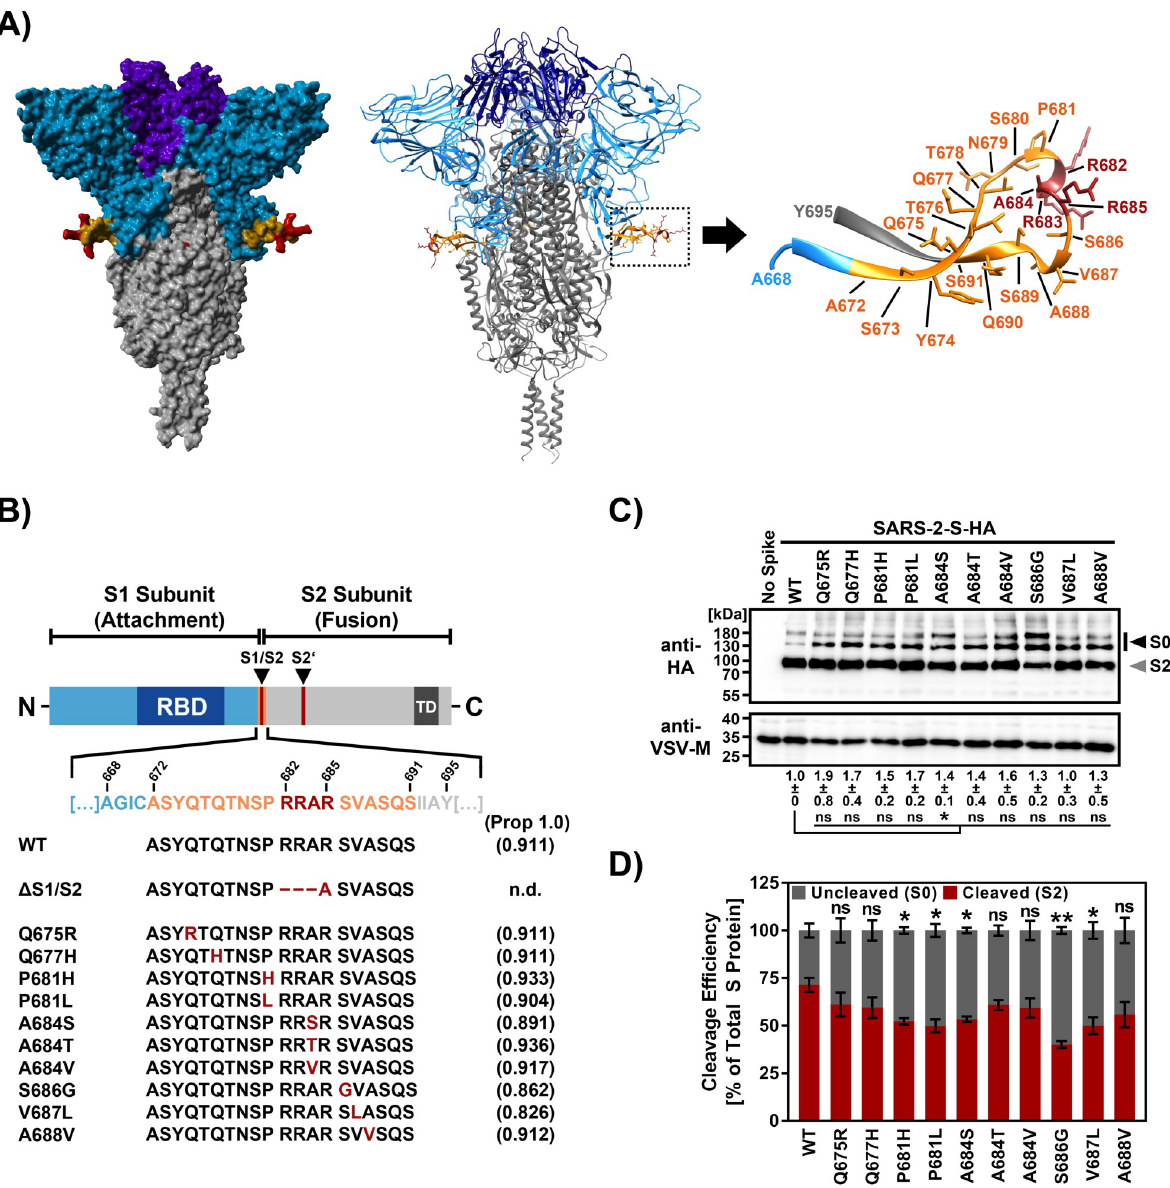
Fig 1. Mutations at S1/S2 site reduce SARS-CoV-2 S cleavage. A) 3D reconstruction of the SARS-CoV-2 S protein trimer. The location of the mutations is highlighted and magnified. Colour code: light blue—S1 subunit with RBD in purple, grey—S2 subunit, orange—cleavage loop encompassing the S1/S2 cleavage site, red—S1/S2 cleavage site. Since the crystal structure PDB: 6XR8 lacks the structural information for residues Q677-A688 of the extended S1/S2 loop, the corresponding structure has been computationally reconstructed. B) Schematic illustration of S protein domain organization. RBD—receptor binding domain, TD—transmembrane domain. The S1/S2 and S2’ cleavage sites are indicated. Mutations located within or adjacent to the S1/S2 site are highlighted. Values in brackets indicate the scores by furin cleavage prediction (ProP 1.0; n.d., not determinable) C) Incorporation of SARS-CoV-2 S proteins into VSV particles. Pseudotyped particles harbouring the indicated S proteins equipped with a C-terminal HA antigenic tag were subjected to immunoblot analysis, using anti-HA antibody. Black and grey filled arrows indicate uncleaved precursor SARS-CoV-2 S (S0) and S2, respectively. Detection of VSV-M served as a loading control. Shown is a representative immunoblot from three independent experiments. Further, total S protein levels in particles were quantified. For this, S protein signals were first corrected with respect to the corresponding VSV-M signals and subsequently normalized (WT SARS-CoV-2 = 1). The average data from three experiments (+/- the standard error of the mean, SEM) are shown below the immunoblot. D) Quantification of cleavage efficiency. For each S protein total S protein signals (S0 + S2) were set as 100% and the relative proportion of the individual S0 and S2 signals were calculated. Displayed are the average data from three independent experiments. Error bars represent the SEM. Statistical significance was analysed by two-tailed Student’s t-test with Welch’s correction (p > 0.05, not significant [ns], p � 0.05, � ; p � 0.01, �� ). WT = wildtype.